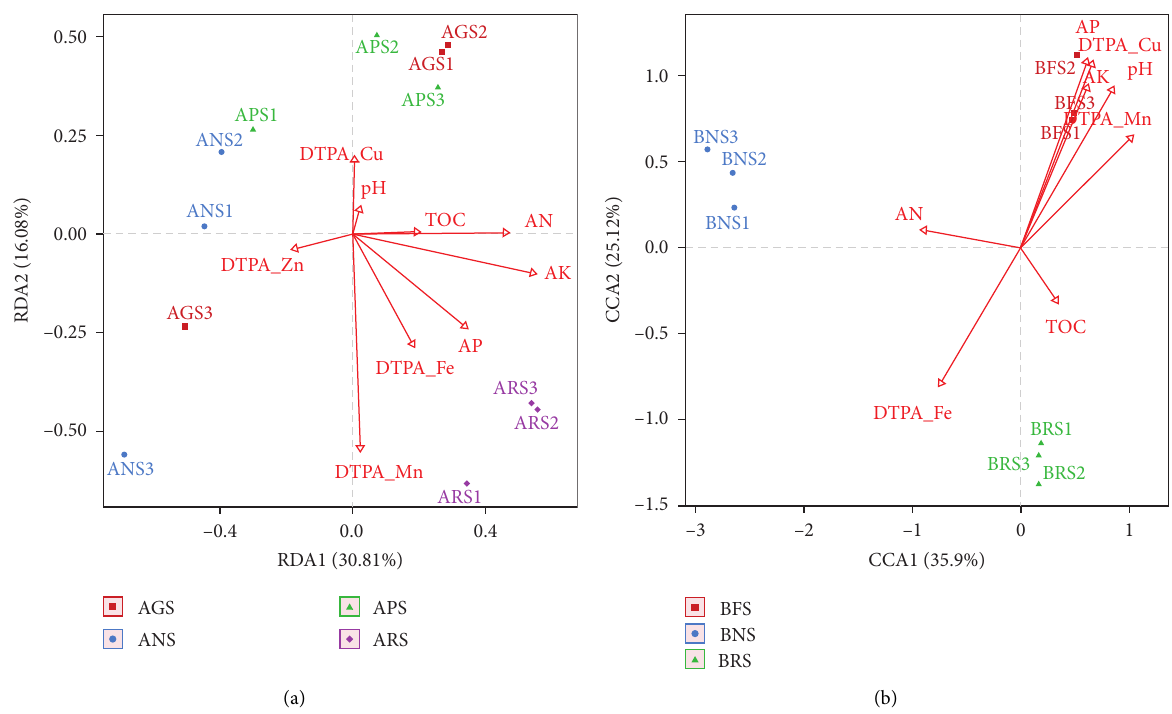
Figure 6: Redundancy analysis to show relationships among soil factors and moss species and bacterial community structures. (a) The DCA analysis of samples collected from mine waste slag areas. (b) The CCA analysis of samples collected from electrolytic manganese slag areas. Table 9: Statistics of bryophytes, genera, and species in electrolytic manganese slag areas. Family Genus Species